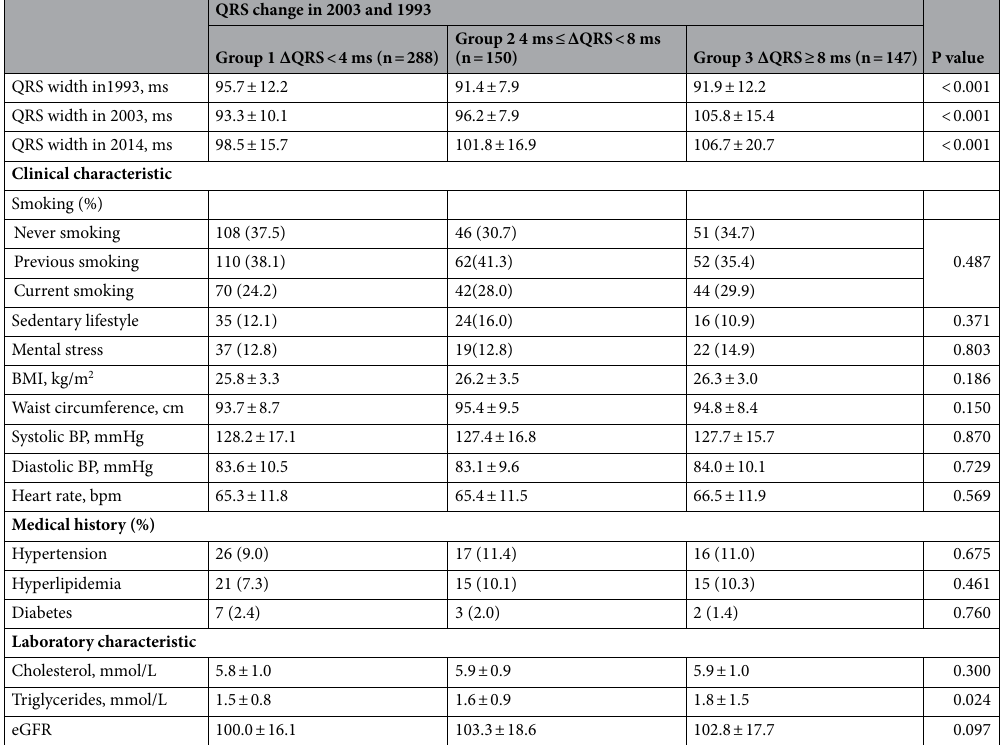
Table 1. Baseline characteristics (1993) according to different QRS change